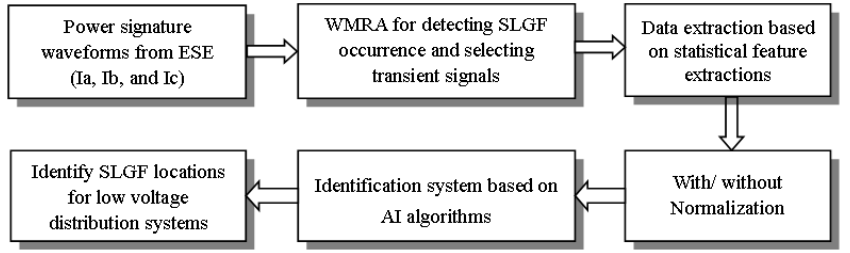
Figure 2. Block diagram of a non-intrusive power fault identification system. ESE: electrical service entry; SLGF: single-line-to-ground fault; and WMRA: wavelet multi-resolution analysis.